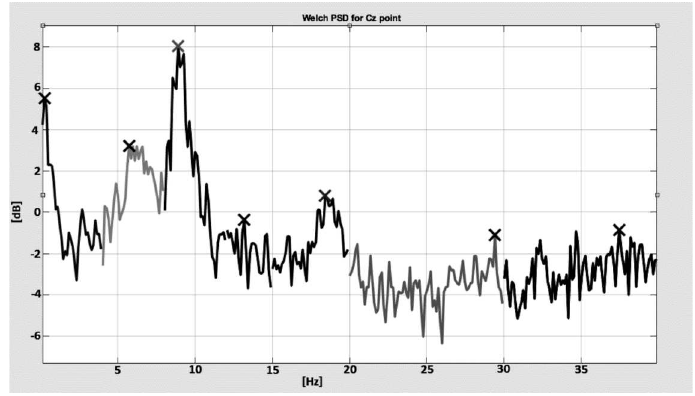
Figure 9. PSD – low frequencies, attention disorders, sample 2